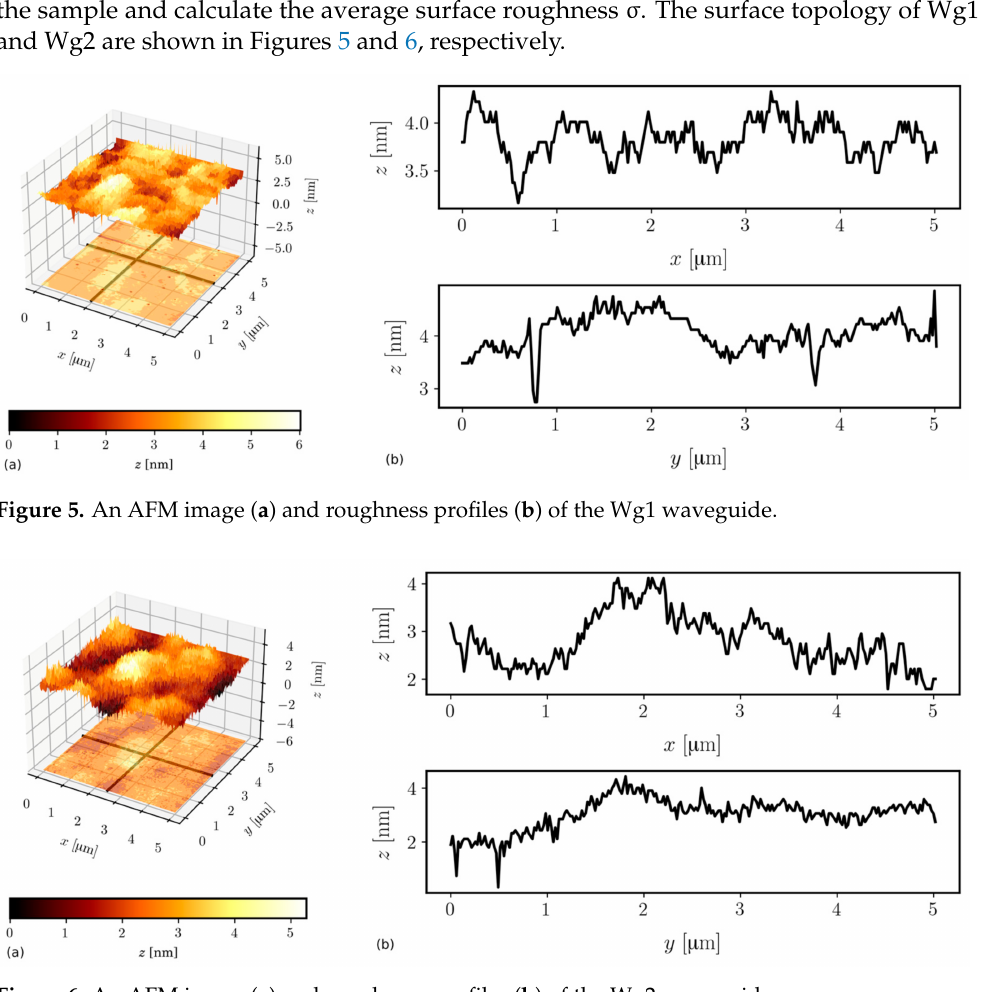
Figure 6. An AFM image ( a ) and roughness profiles ( b ) of the Wg2